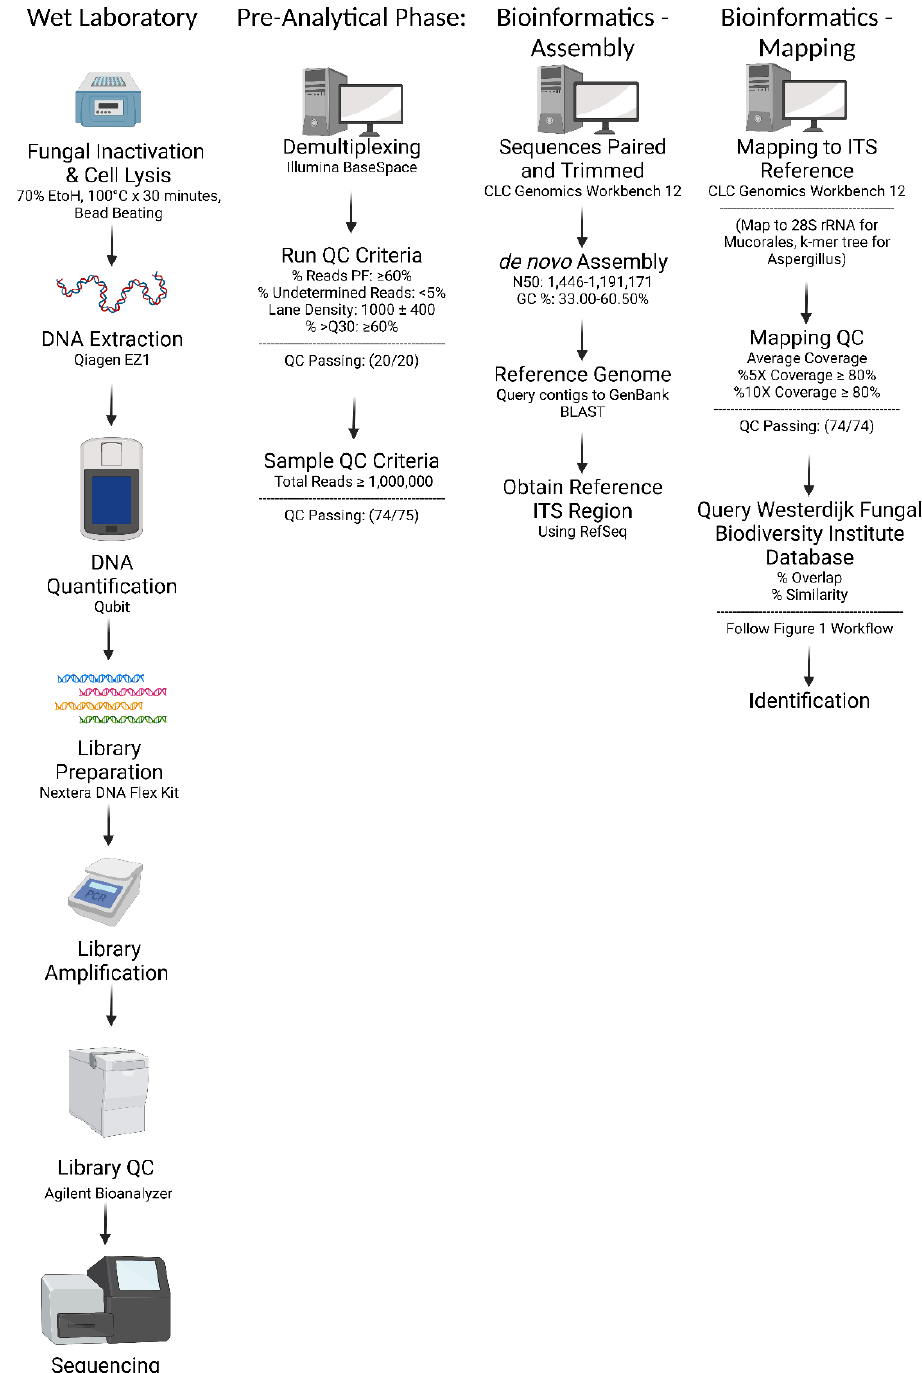
Figure 1. The Workflow of the WGS Test for Fungal